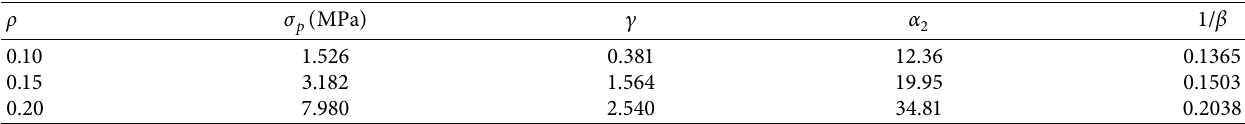
c , α , and 1/ β in equation p , 2